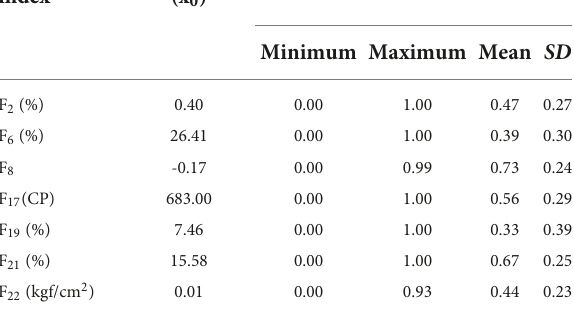
TABLE 7 Ideal value and normalized value of core quality index of sweet potato